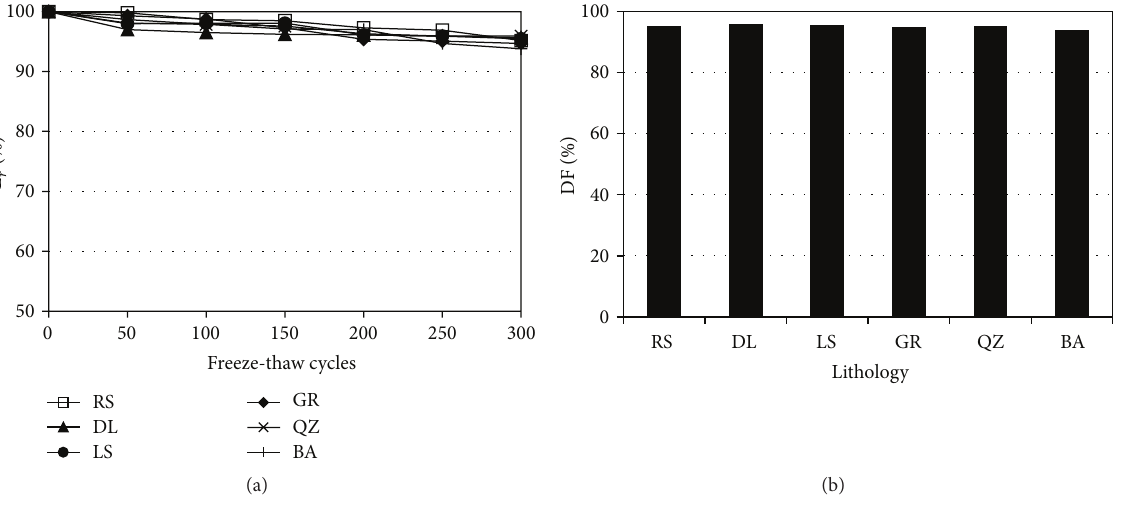
Figure 8: Effect of lithology on frost durability of C60 concrete: (a) 𝐸 𝑟 . (b)